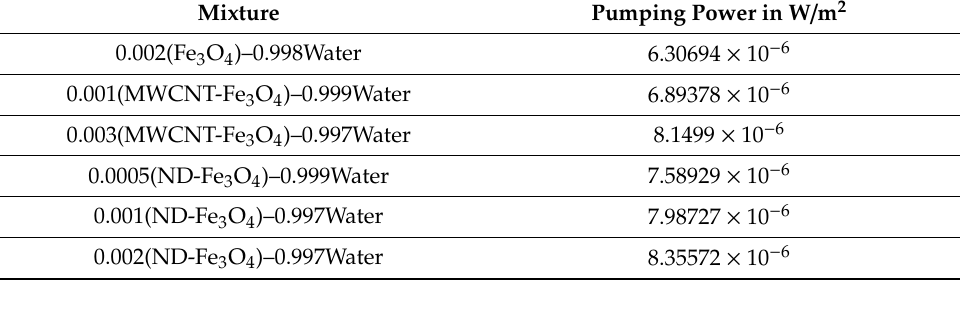
Figure 10. Pumping power for two mixtures. ( a ) Al 2 O 3 –Cu mixtures, ( b ) SiO 2 –TiO 2 mixtures. Table 3. Pumping power.